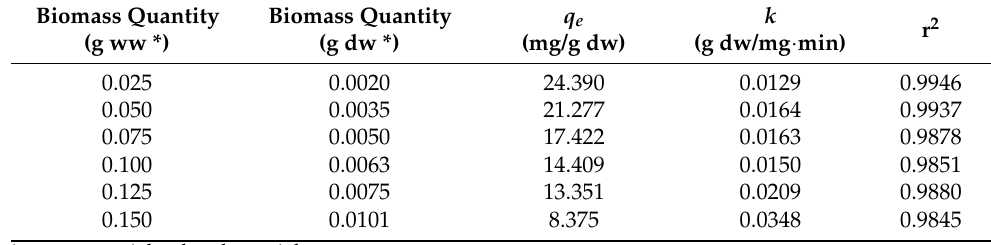
Table 3. Parameters of the pseudo-second-order kinetic model adjusted to the Au biosorption on different quantities of Aspergillus tabacinus pellets.